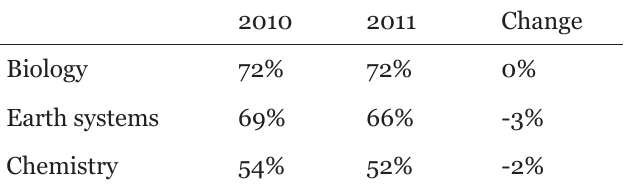
Statewide Changes in CRT Scores in Biology, Earth Systems, and Chemistry 2010–2011